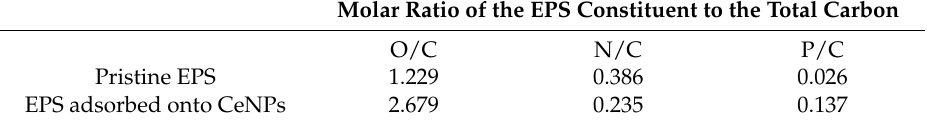
Table 4. Summary of the XPS analysis of major constituents in pristine EPS and EPS adsorbing onto CeNPs. The molar ratio was semi-quantitatively calculated by integrating the peak of each constituent and normalized by that of total